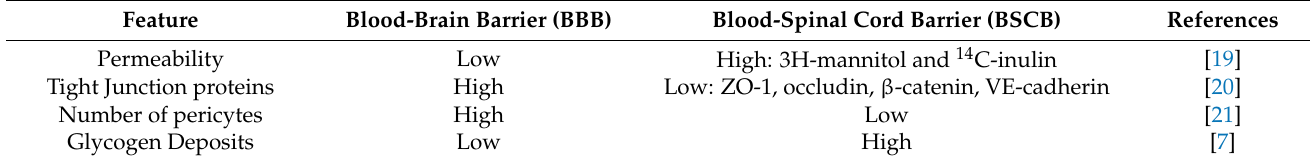
Table 1. Key differences between BBB and